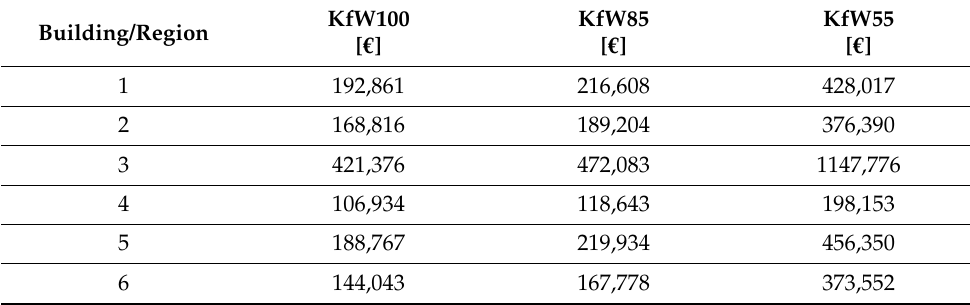
Table A2. Refurbishment cost for the different building standards.